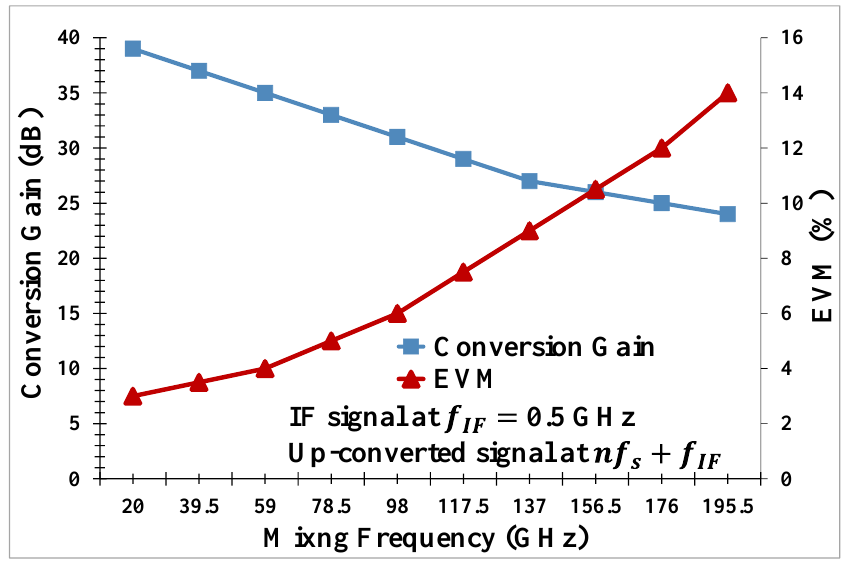
Figure 4. Conversion gain and EVM of the signal to be mixed that loads QPSK at 𝑛𝑓 𝑠 + 𝑓 𝐼𝐹 . Up-conversion simulations of the signal to be mixed that loads QPSK data are assessed at the data rate of 5 Gbit/s. Two subcarriers are entered into the SOAs electrodes for differential modulation. The quality of the mixing is evaluated through the error vector magnitude (EVM) [27] calculated in order to estimate the quality of the signal to be mixed. The BER_El-M-QAM module is employed to compute the bit error rate (BER) of the signal to be mixed. Hence, EVM values are found from the BER [28]. The EVM boundary of the QPSK data is 17.5%